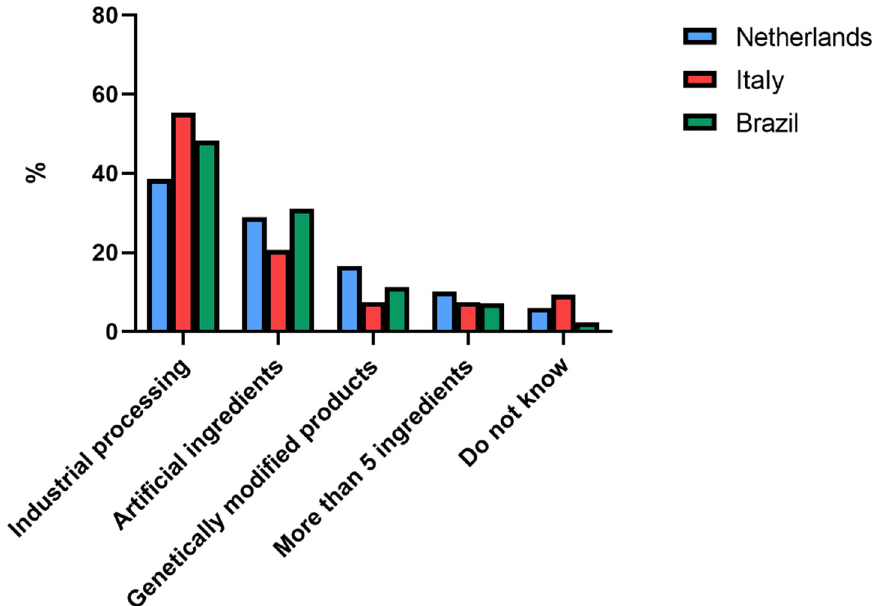
Figure 3. Answers (%) to the multiple choice question: “According to you, ultraprocessed foods are (more than one option can be selected): . . . ” by Dutch ( n = 277), Italian ( n = 204), and Brazilian ( n = 181) consumers.